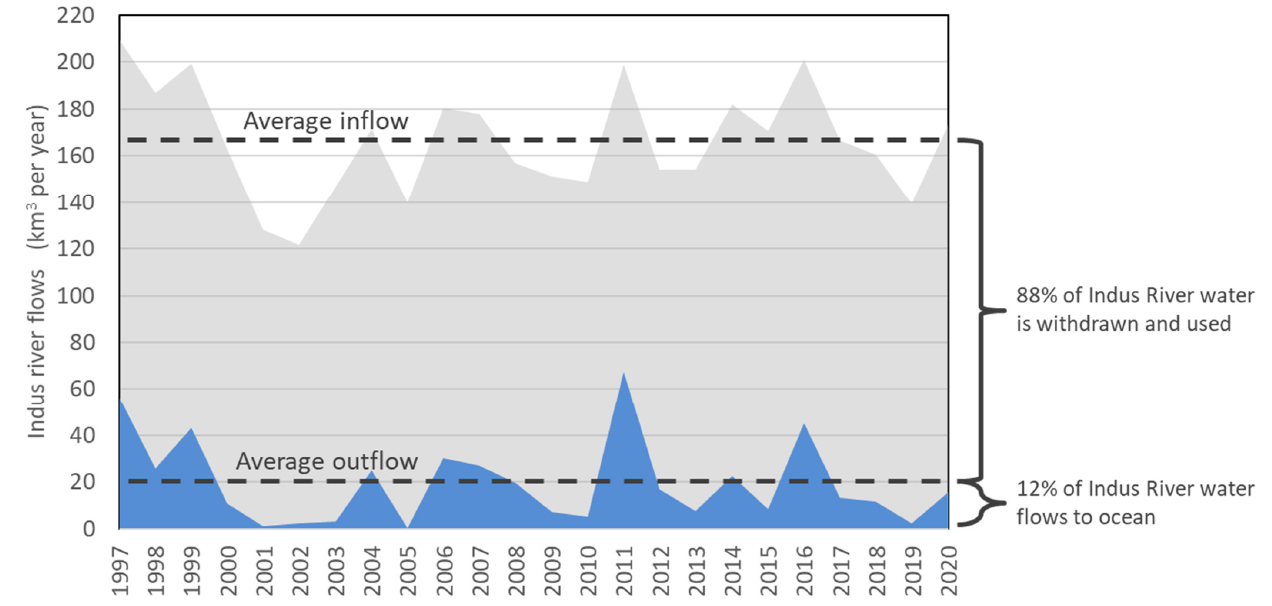
Figure 5. The Indus River basin is effectively closed, with little opportunity to increase surface water extractions for Pakistani cities.